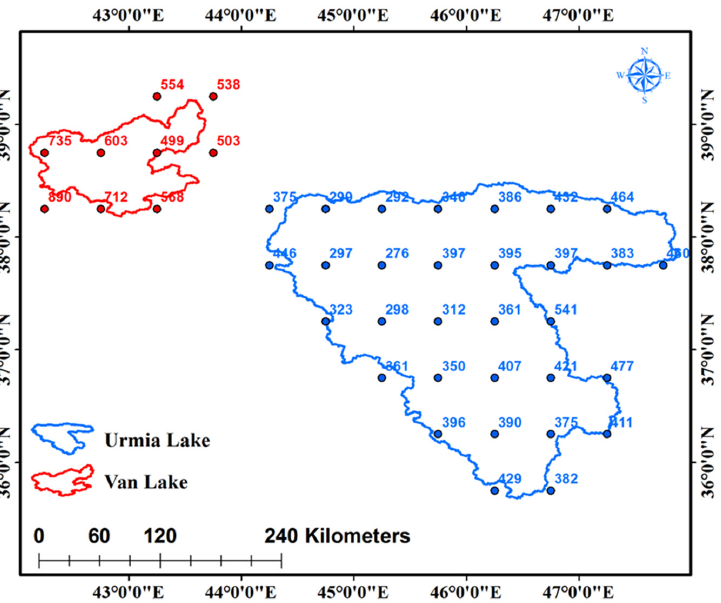
Figure 3. Gridded EU-WATCH data covering LU and LV (mm).